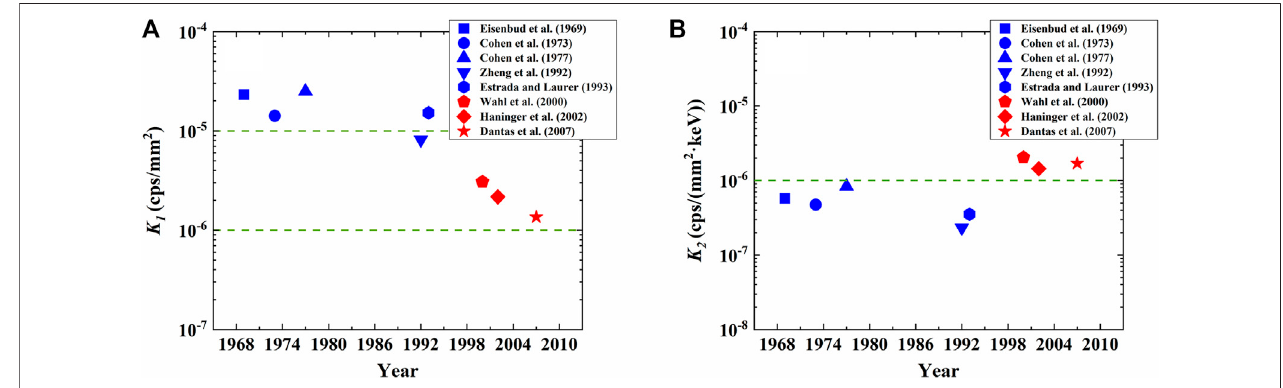
FIGURE 3 | Dependence of background count rate on active area and width of ROI for various studies. In panel (A) , K 1 represents the background count rate per active area; in panel (B) , K 2 represents background count rate per active area per ROI energy.